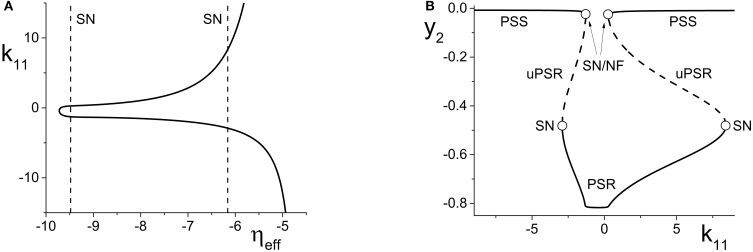
(A) The non-linear behavior of ηeff as a function of k11 for the excitatorily-coupled response system. ηeff is plotted horizontally to facilitate comparison with Figure 2A. The parameters are: η1 = −0.05, Δ1 = 0.05, η2 = −10, with the inter-population coupling fixed at k21 = 2.0. (B) The one-dimensional bifurcation diagram showing the asymptotic value of y2 = Im(z2) vs. k11. Solid and dashed curves indicate stable and unstable equilibria, respectively. The parameters are as in (A), with Δ2 = 0.5 and k22 = 9.